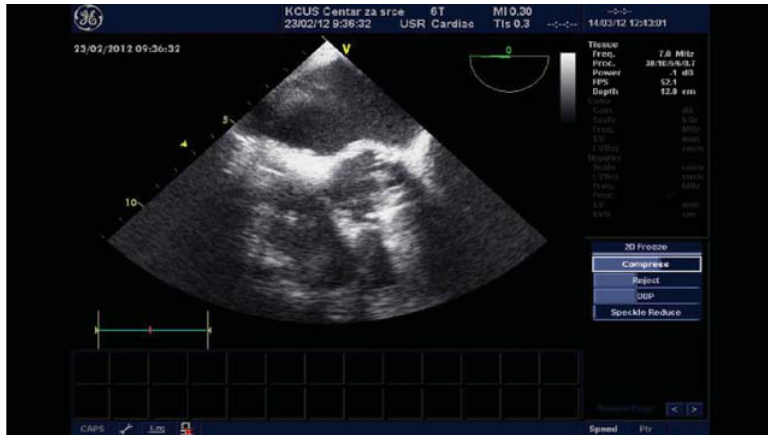
FIGURE 4. TEE : Postin fl ammatory aortic root fi